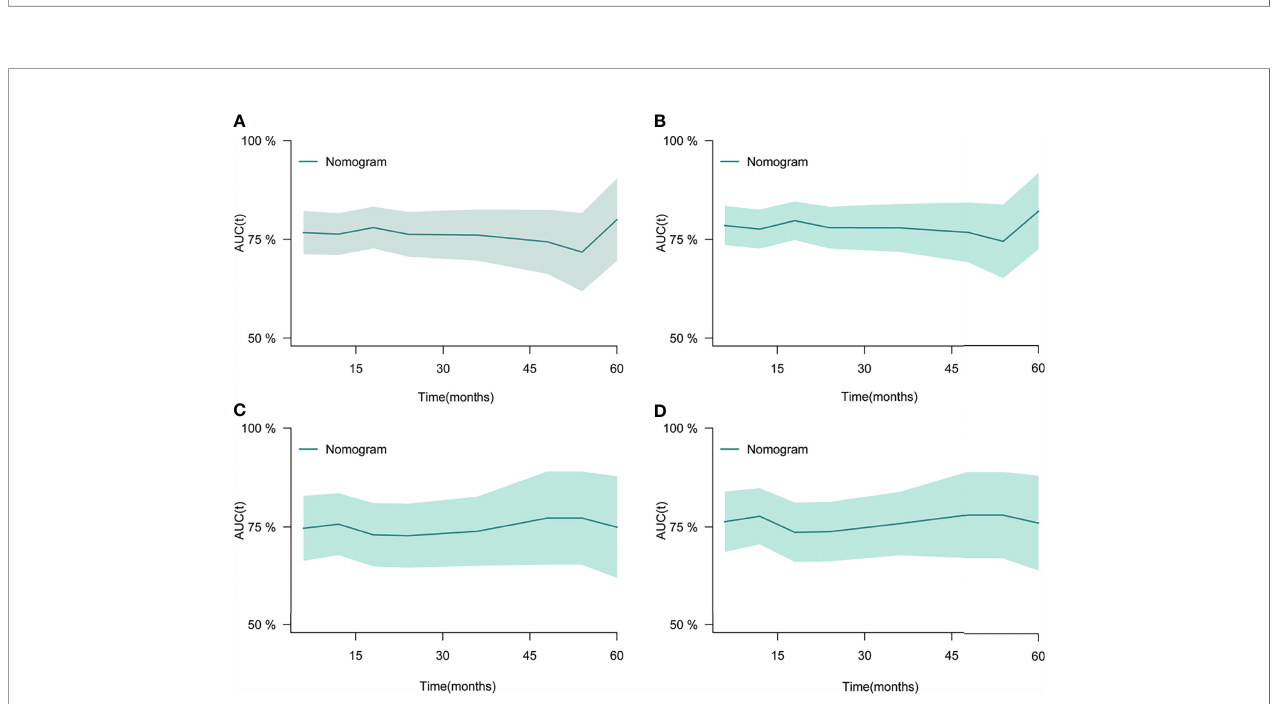
FIGURE 7 | The time-dependent ROC curves of the nomogram for OS in the training set (A) and validation set (C) . The time-dependent ROC curves of the nomogram for CSS in the training set (B) and validation set (D) . ROC, receiver operating curve; OS, Overall